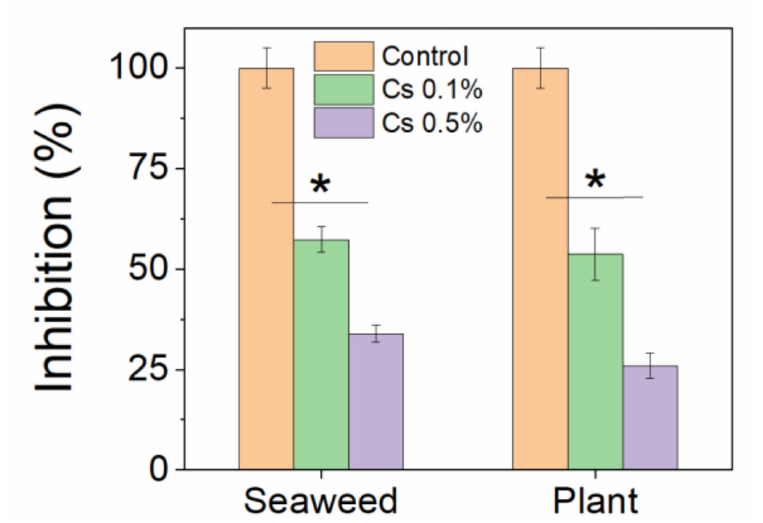
Figure 9. Antimicrobial effect of chitosan-coated paper was assessed by measuring the degree of inhibition (%) of E. coli growth on seaweed (High S%) paper and plant paper coated with chitosan (M-Cs) (* p <